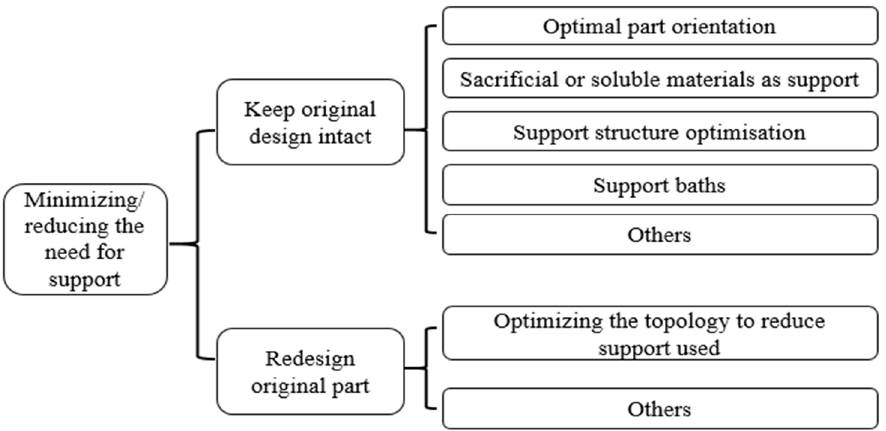
Figure 4. Main categories of support structure methods for 3D printing.